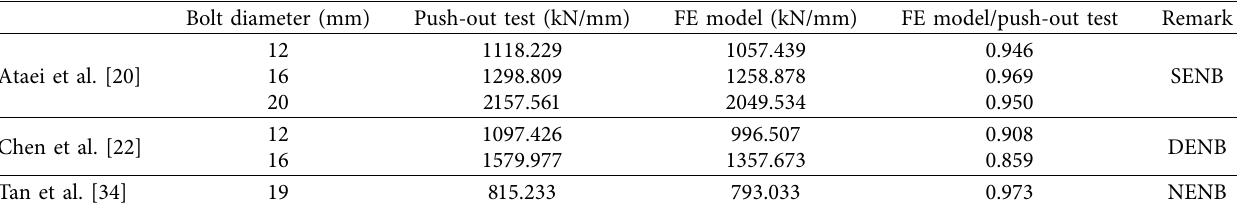
Table 3: Comparisons between FE results and experimental